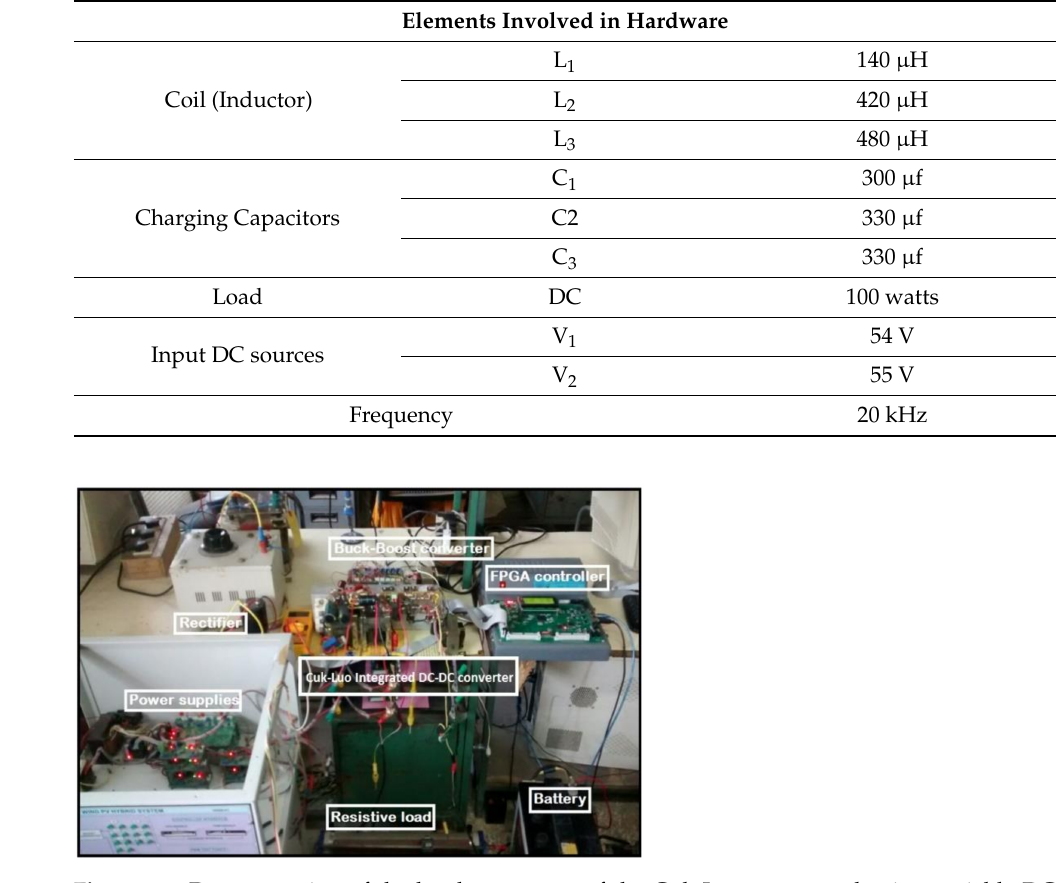
Figure 12. Demonstration of the hardware setup of the Cuk-Luo converter having variable DC input